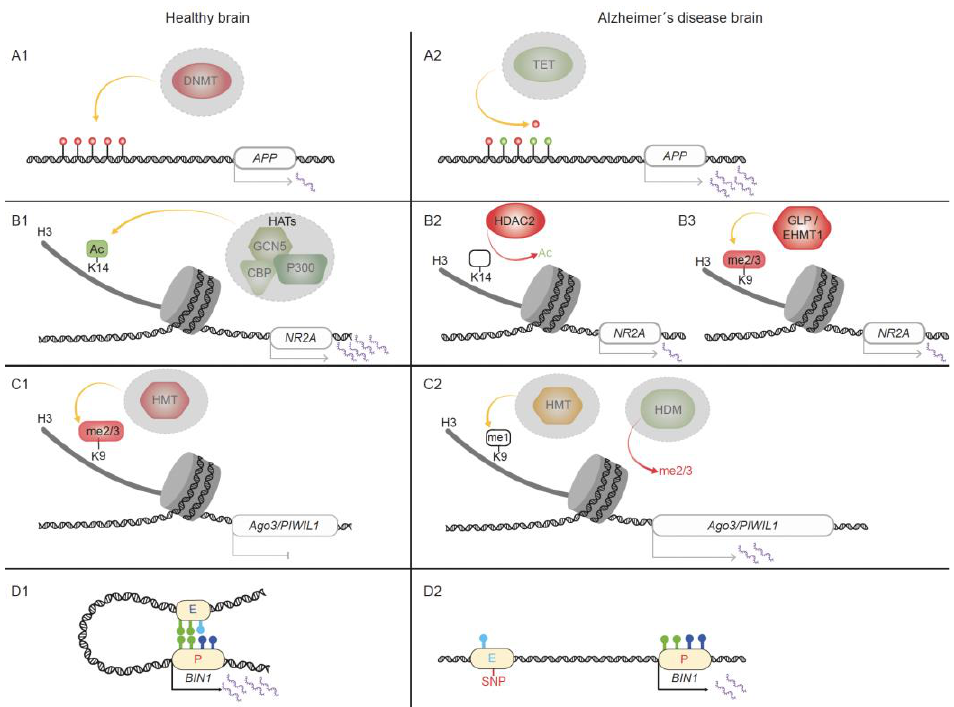
Figure 4. Local alterations in the epigenome and 3D chromatin architecture contribute to transcrip- tional dysregulation in AD. Schematic illustrations of examples of epigenetic ( A – C ) and chromatin remodeling ( D ) changes discovered in the brain of AD animal models and postmortem brain tissue of AD patients, compared to healthy controls. The chromatin-modifying enzymes are also depicted; those that have been demonstrated to contribute to the implicated epigenetic mechanisms are shown in bright format, while those potentially involved, are shown in shadow format. ( A ) CpG methylation (red circles) of the APP gene promoter in brain samples from ( A1 ) healthy and ( A2 ) sporadic cases of AD is depicted; unmethylated CpG (green circles) in AD is paralleled with increased APP mRNA levels. ( B ) H3K14ac associated with the promoter of the plasticity gene NR2A in brain samples from ( B1 ) healthy and (B2-3) AD mice is shown; the loss of this active mark ( B2 ) and/or the enrichment in the repressive mark H3K9me2/3 ( B3 ) correlates with reduced NR2A mRNA levels in AD. ( C ) H3K9me2/3 associated with the promoter of the normally heterochromatic and silenced gene Ago/PIWI1 in brain samples from ( C1 ) healthy and ( C2 ) AD mice is depicted; the loss of this repressive mark correlates with the induction of Ago/PIWI1 mRNA levels in AD mice and AD patients. ( D ) The BIN1 gene promoter and its long-distance enhancer element in microglia derived from brain samples from ( D1 ) healthy and ( D2 ) AD mice, are shown; loss of this EPI in AD correlates with reduced expression of BIN1 mRNA. The location of the AD risk variant rs6733839 is also depicted in the enhancer sequence. For more details, see text.